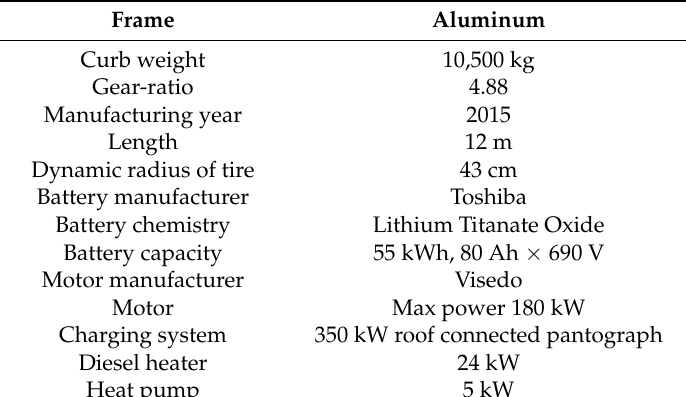
Table 1. Specifications of the measured buses.